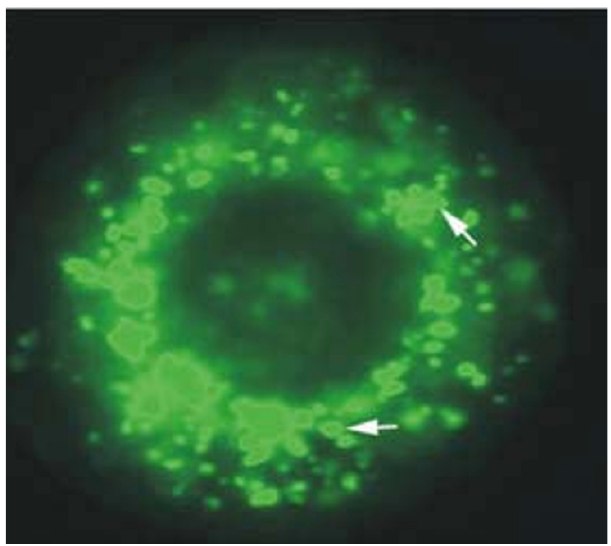
Figure 2 Fluorescence microscopy of a S2 cell transfected with the Ala221fs mutation in fusion with GFP (vec- tor pEXII). None of the different layers analysed by fluores- cence microscopy showed a membrane insertion of P0-GFP. Fluorescent cytoplasmic vesicles (arrows) are clearly visible. The nucleus is free of fluorescence (see fig. 4).